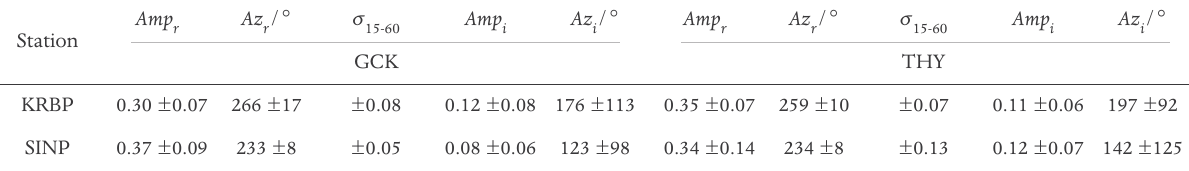
Table 2. Results of the transfer functions analysis for KRBP and SINP, using observatories GCK and THY as a reference point. All entries are written as mean ± standard deviation . Amp and Az are the lengths and azimuths of induction arrows, indices ( r ) and ( i ) apply to the real is the standard deviation of the length of the real arrows in the period interval of 15-60 min. The values and imaginary arrows, and v 15-60 refer to the average and the standard deviation of data obtained from periods of (10.7 min, 12.8 min, 18.3 min, 25.6 min, 32.0 min and 64.0 min) for KRBP, and of (12.8 min, 18.3 min, 21.3 min, 42.7 min and 64.0 min) for SINP.